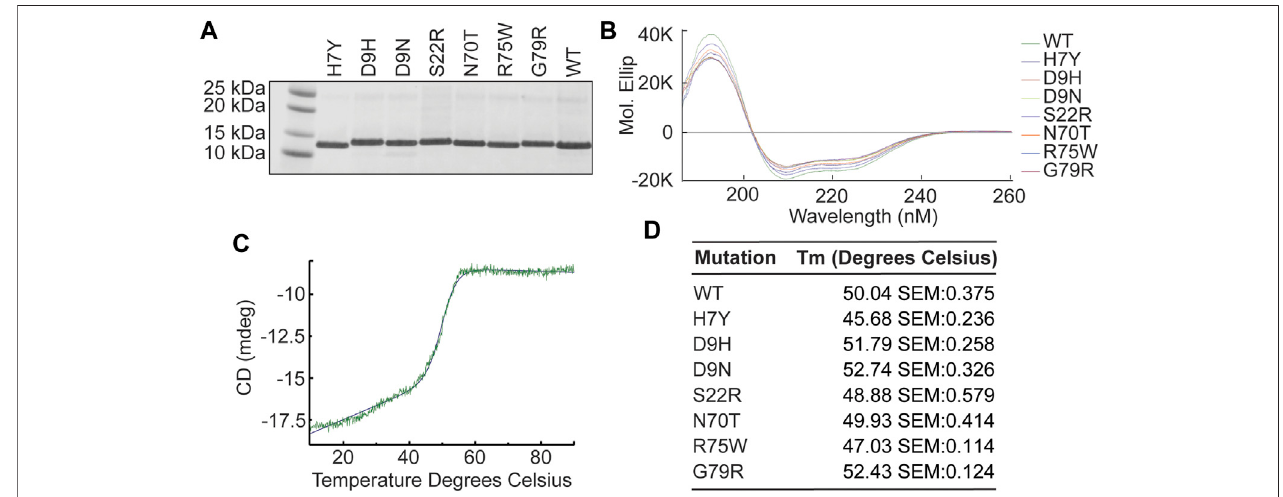
FIGURE 2 | Banf1 variants do not signi fi cantly alter Banf1 secondary structure. (A) Banf1 His-tagged WT and variant proteins were expressed and puri fi ed from E.coli cells. Puri fi ed proteins were runon an SDSPAGEgel and stained withCoomassie. (B) Representative molecular ellipticity trace over awavelengthof185 – 260 nm (n (cid:1) 3). The molecular ellipticity values were calculated based the molar concentration of each protein sample and the CD values, which were obtained using JASCO J- 1500 circular dichroism spectrophotometer. (C) Representative curve fi tting of thermal stability analysis of point CD measurements at 222 nm over a temperature gradientfrom10to90 ° C,takeninthreetechnicalrepeatsevery0.1 ° C. (D) ThermaldisassociationtemperatureofBanf1wild-type,H7Y,D9H,D9N,S22R,N70T,R75W, and G79R variants.